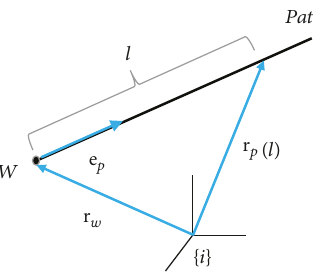
Figure 5: Parametric representation of a straight-line